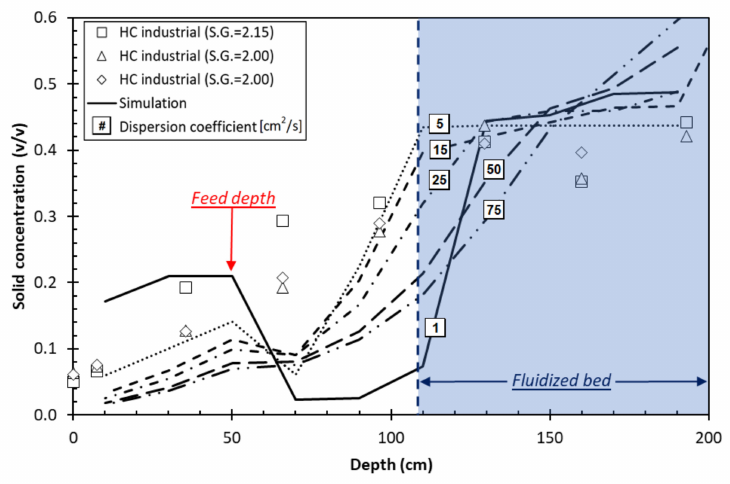
Figure 5. Influence of D on the solid concentration in the simulation of an industrial